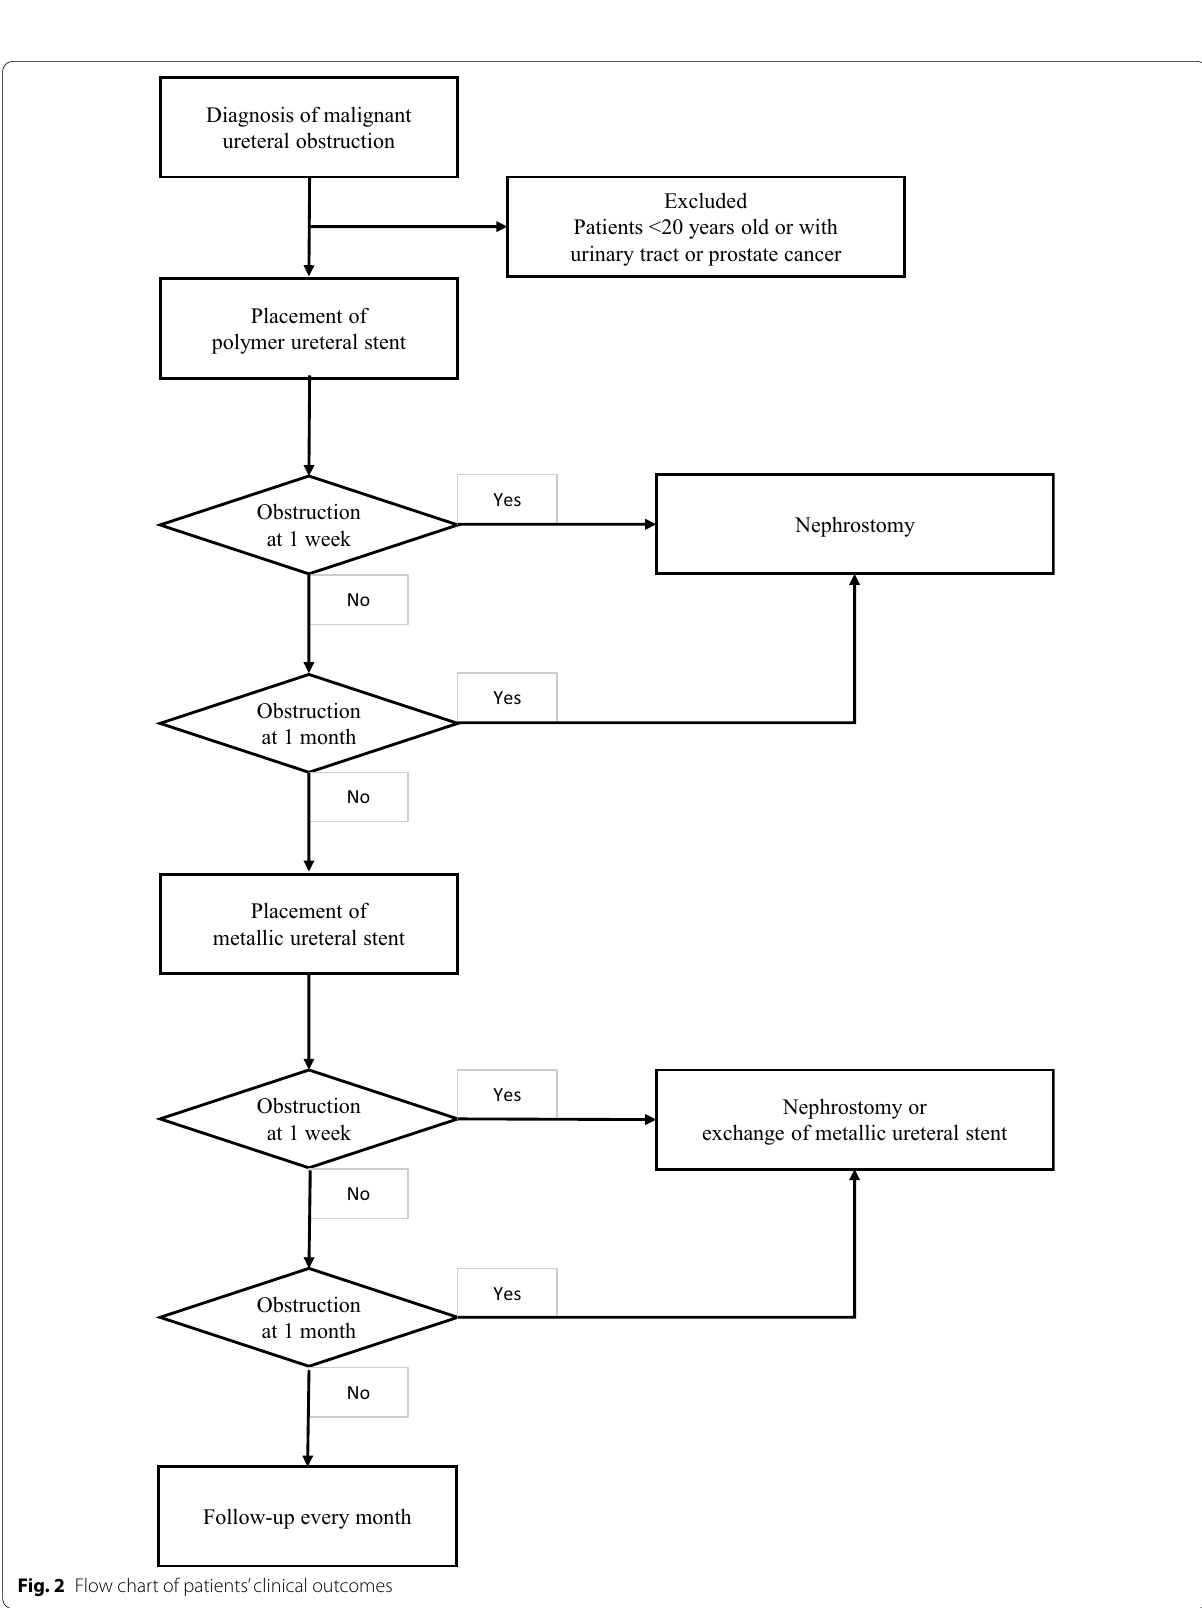
Fig. 2 Flow chart of patients’ clinical